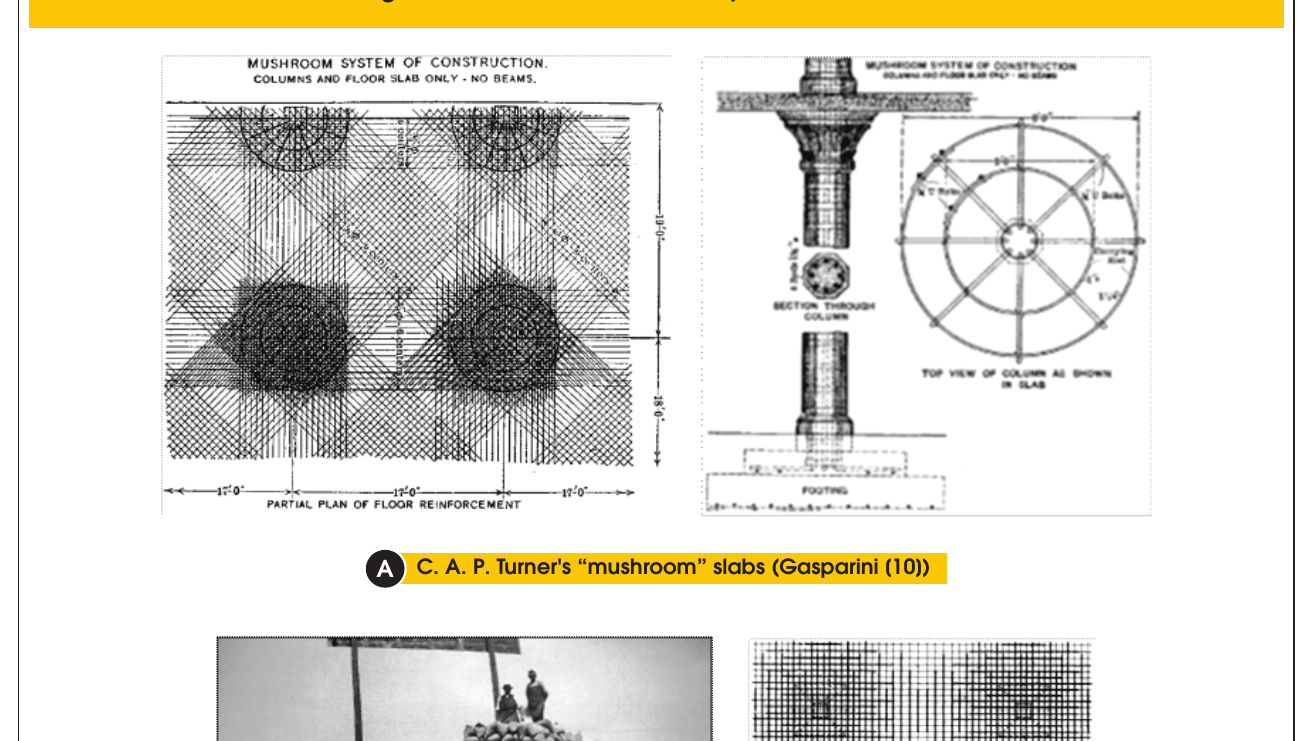
Figure 2 � �etails of t�e de�elo��ent of flat